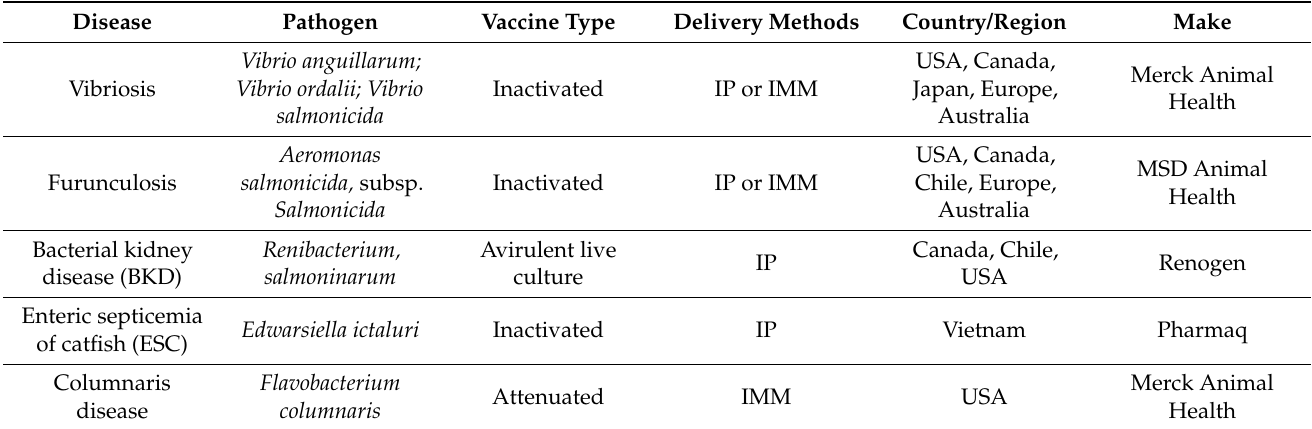
Table 2. USDA Approved Bacterial Fish